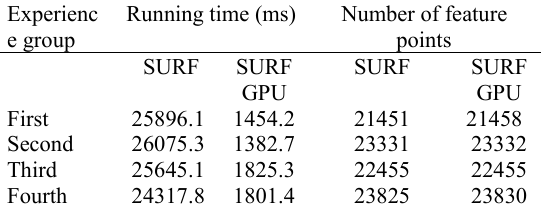
Table 2. Experimental comparison between SURF and